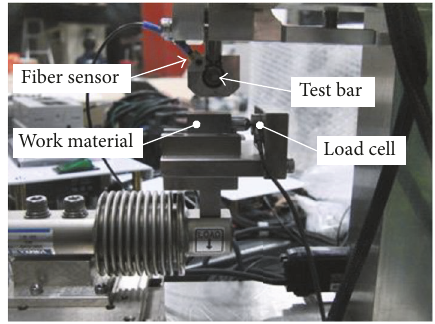
Figure 5: Experimental apparatus.